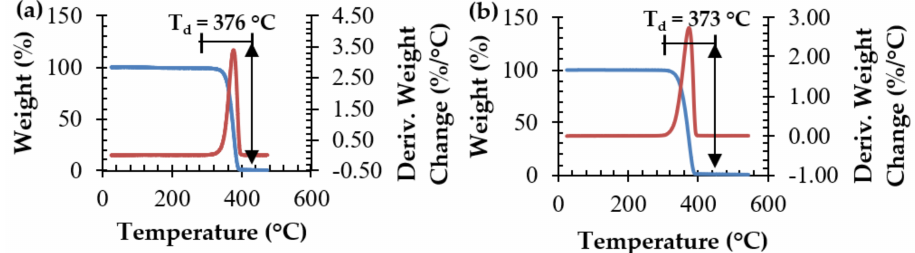
Figure 13. Thermal degradation of ( a ) stereocomplex PLA and ( b ) PLLA